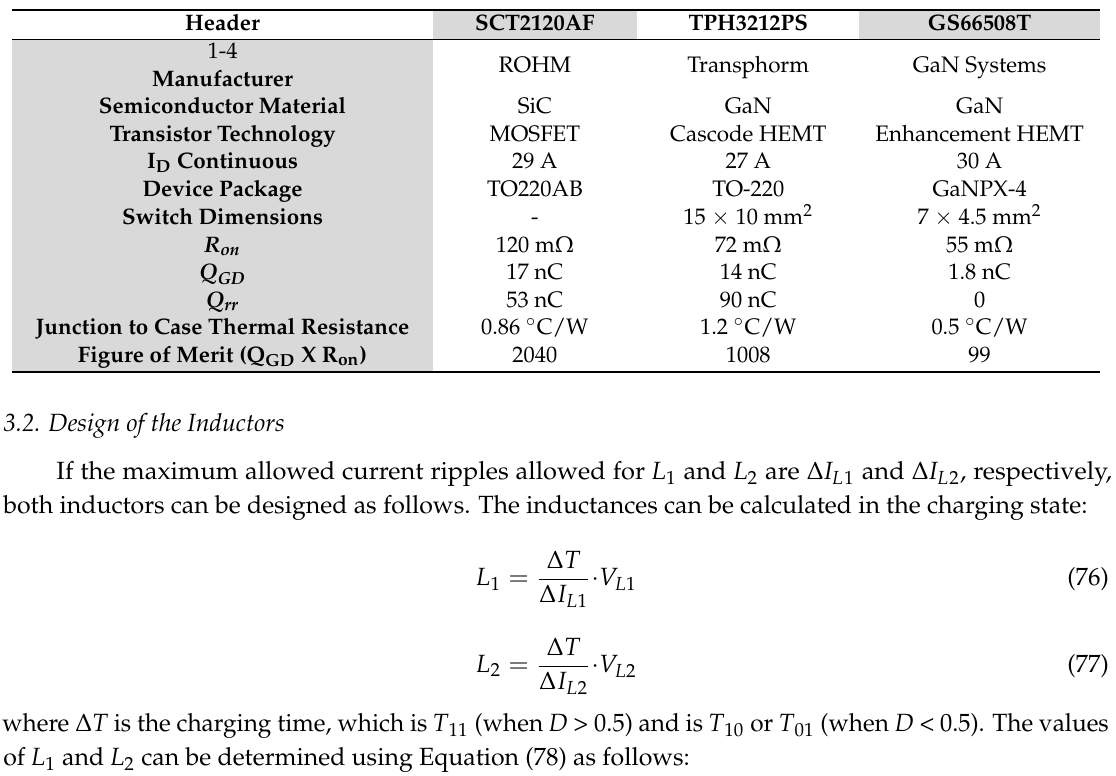
Table 2. Comparison between wide-bandgap (WBG) transistors available in the market. Header SCT2120AF TPH3212PS GS66508T Transphorm GaN Systems Manufacturer